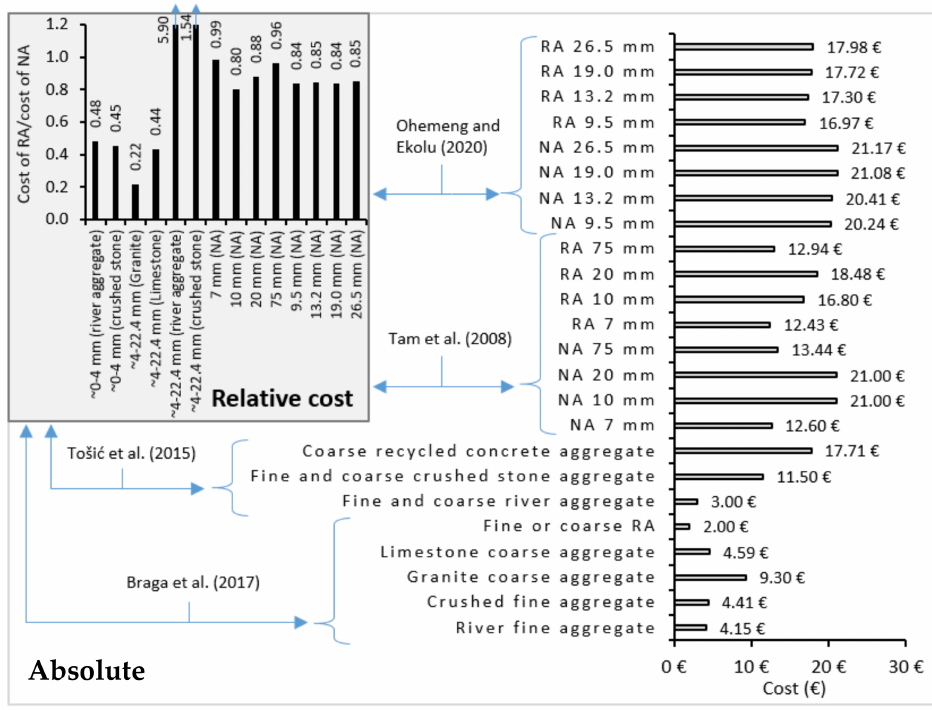
Figure 3. Absolute and relative costs of individual types of aggregates (cost of raw material produc- tion, per